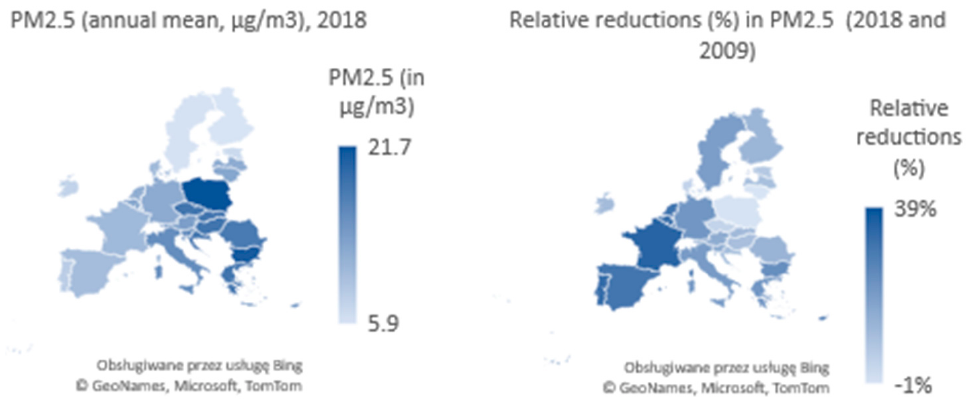
Figure 1. Spatial distribution of the level of PM2.5 and relative reductions (%) in PM2.5 in 2009–2018 (EU-27 Member States).